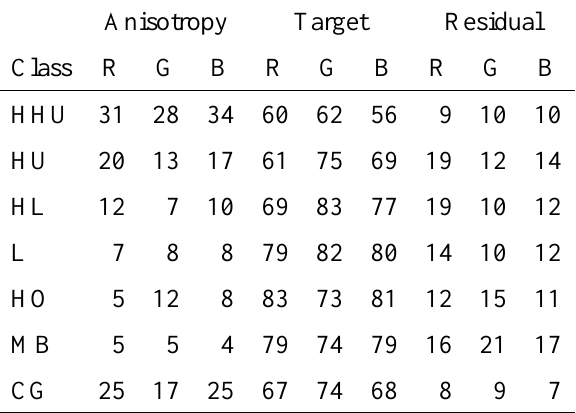
Table 6. Partition of DN (mean values in 5 × 5 window) variance between the terms of the mixed- effects models (Equation 3). Percentages (%) of total variance.